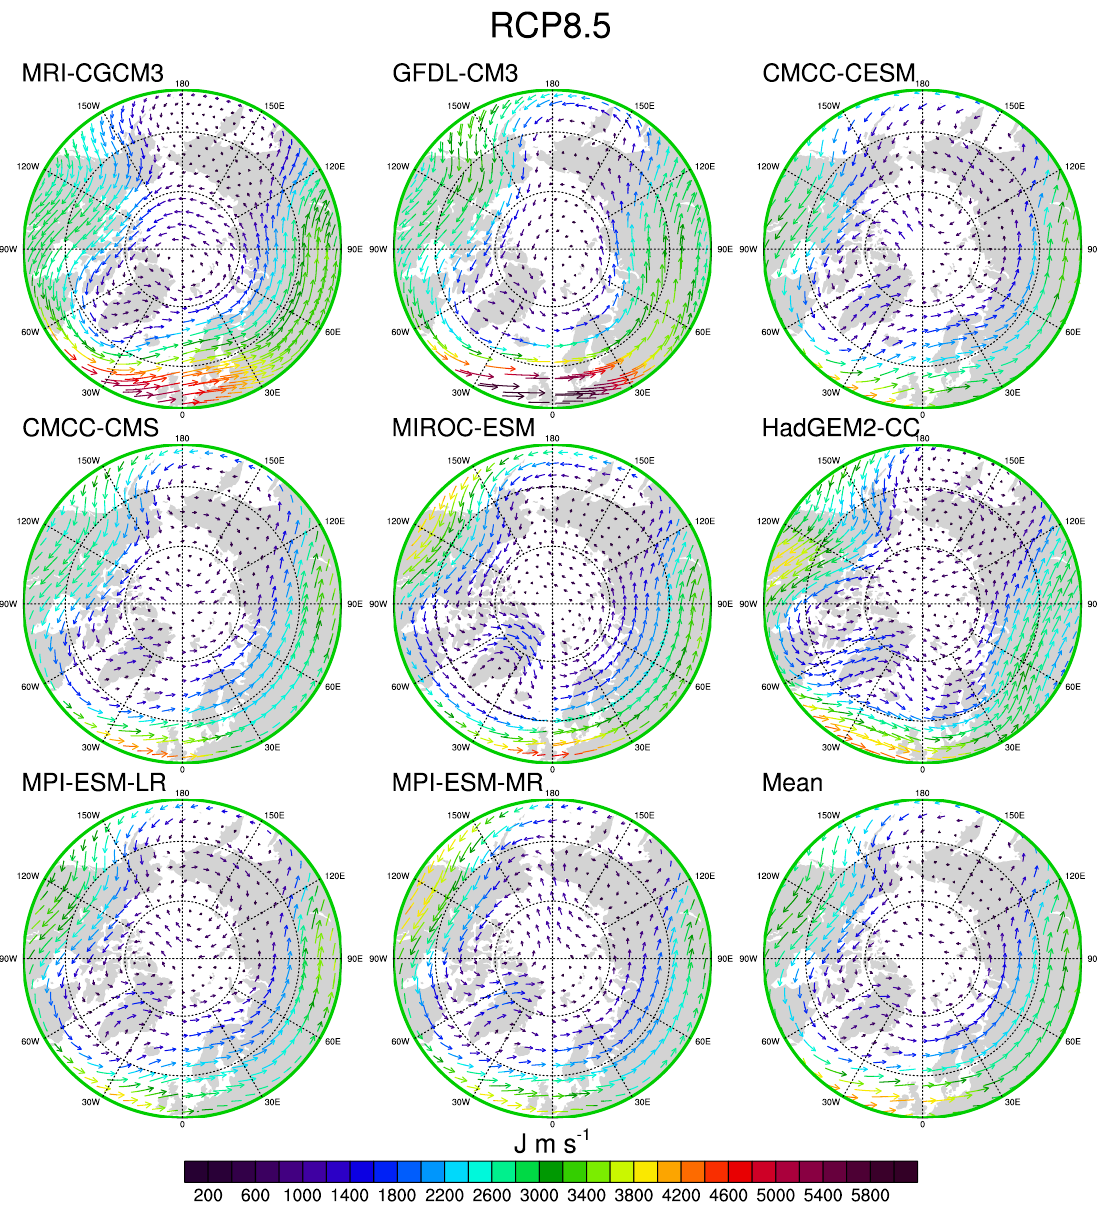
Figure 6. Same as in Figure5, but for the Continental